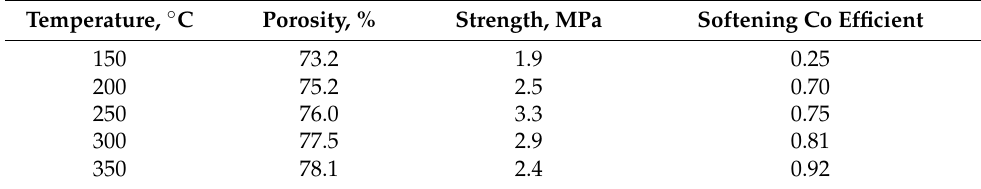
Table 6. Effect of firing temperature on the properties of granules with a diameter of 10 mm.